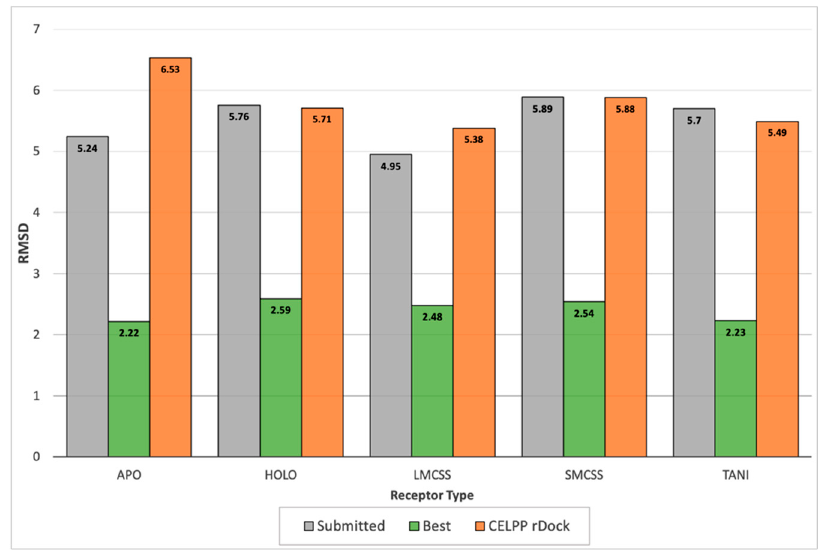
Figure 6. Median RMSD for the submitted pose compared to the best pose generated by the pipeline. The CELPP rDock workflow values are obtained from the D3R website (https://drugdesigndata.org/about/celpp2-charts accessed on 1 May 2021).